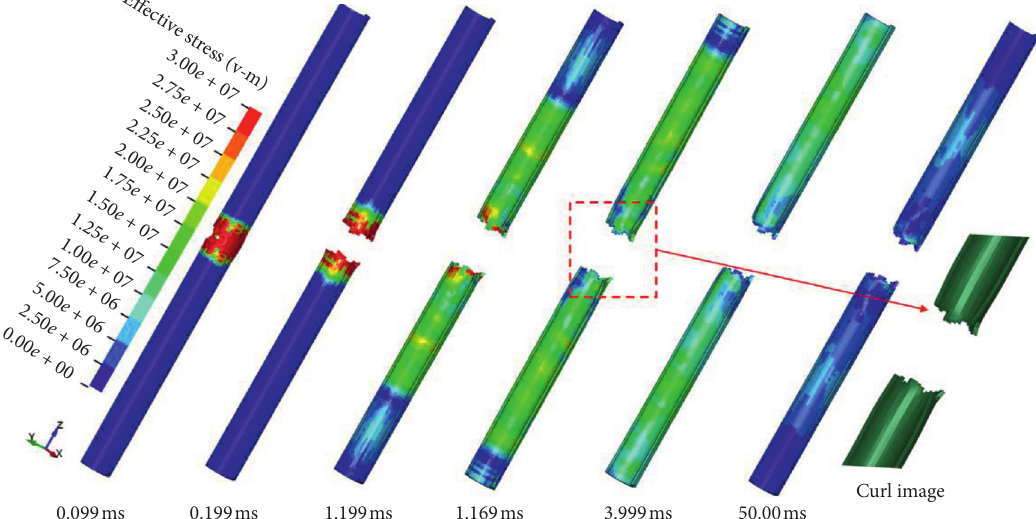
Figure 7: Stress distribution and damage process of the PE pipe.